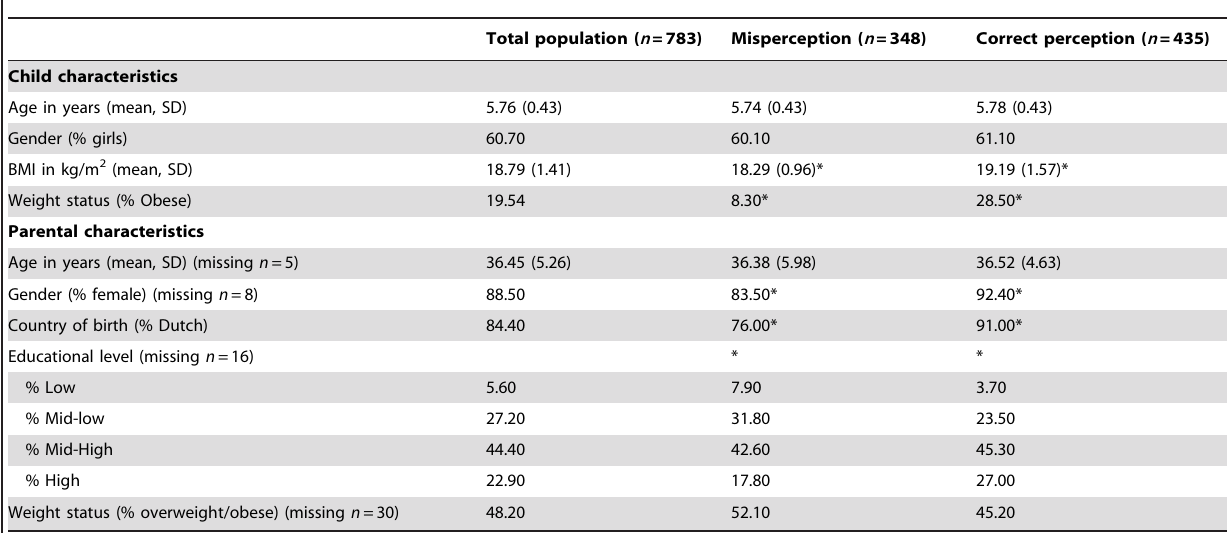
Table 1. Child and parental characteristics ( n =